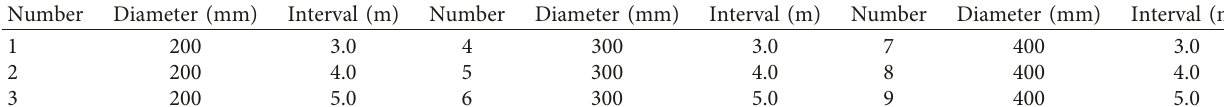
Table 6: The numerical simulation schemes for different diameters and